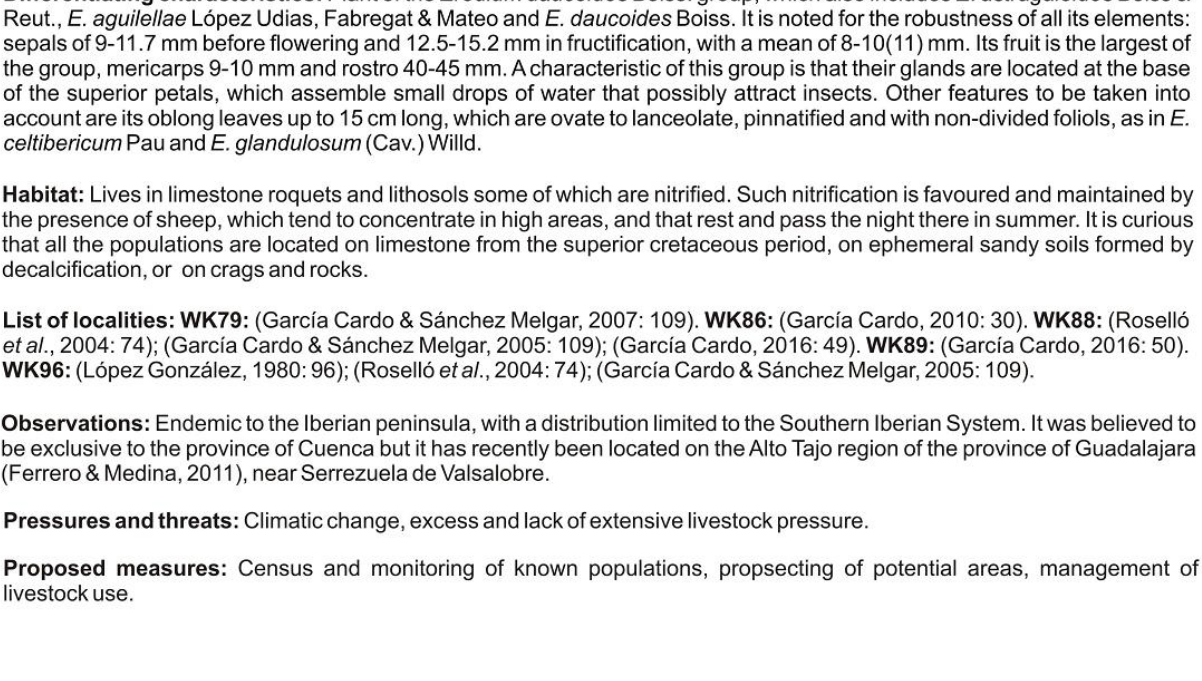
Figure 3. Example sheet of an endangered species (Roselló & al ., 2004; García Cardo,